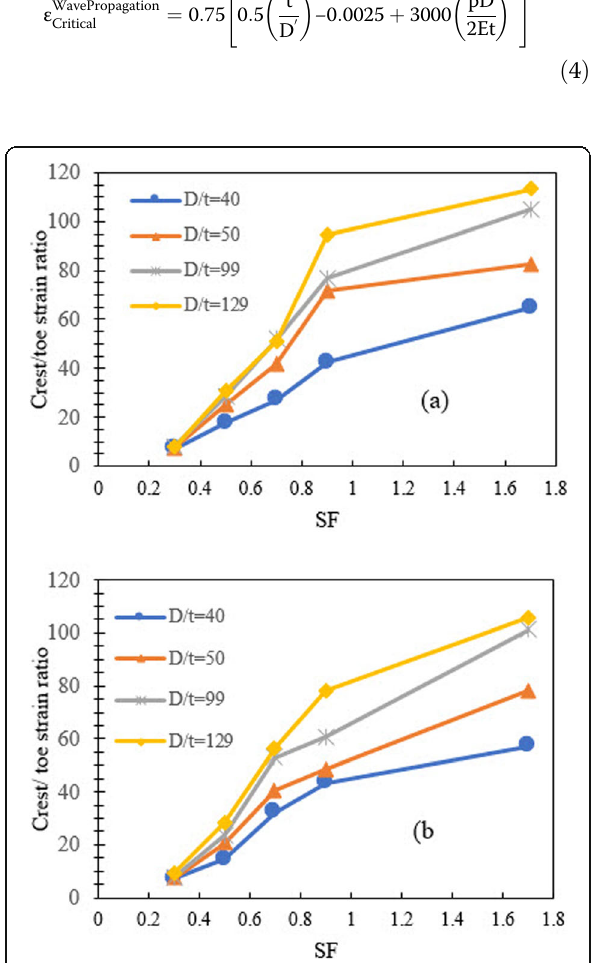
Fig. 8 Effect of SF on amplification of seismic input motion (harmonic motion amplitude= 0.8 g) at various frequencies